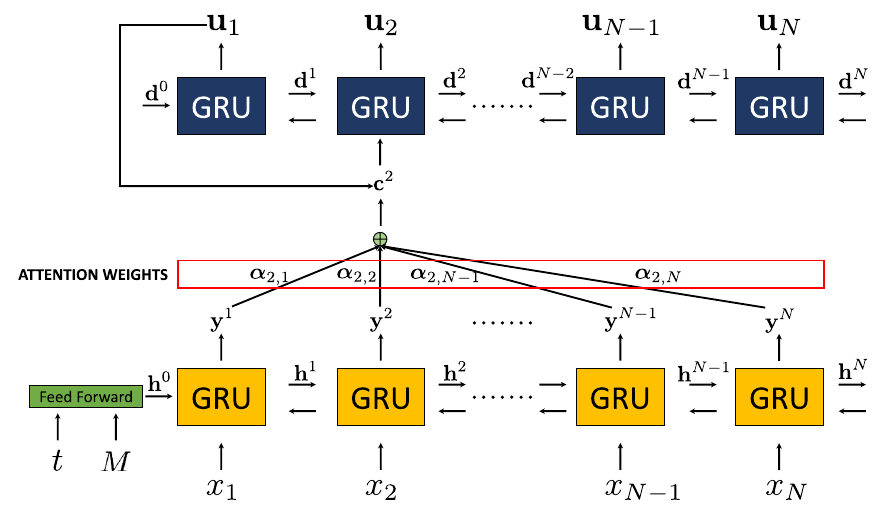
Figure 1. Architecture of physical attention neural network for the prediction of the variable u 2